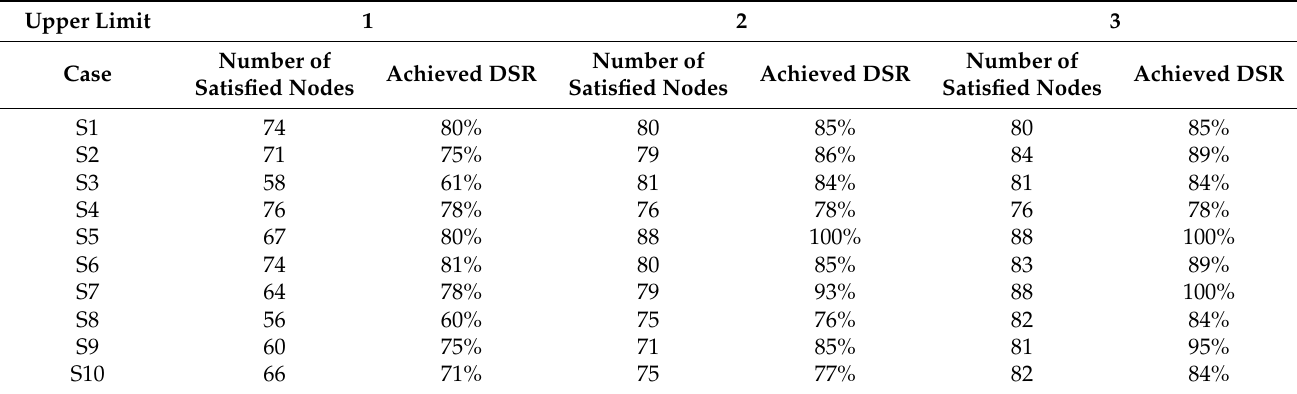
Table 5. Sensitivity analysis of the number of sectionalizing